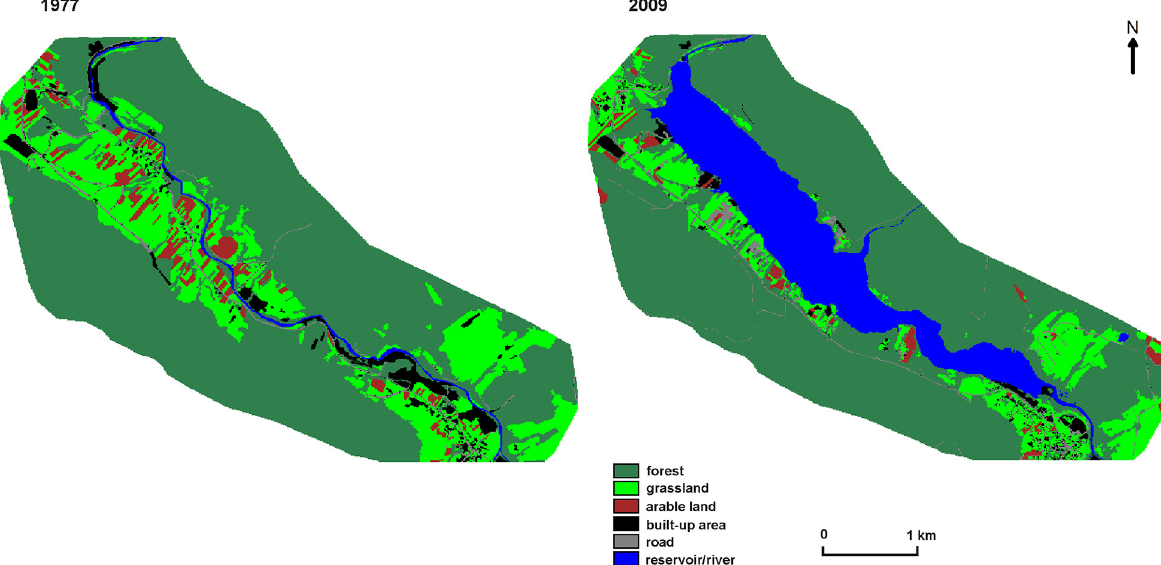
Fig. 5. land use in the Ropa river valley in 1977 and 2009.